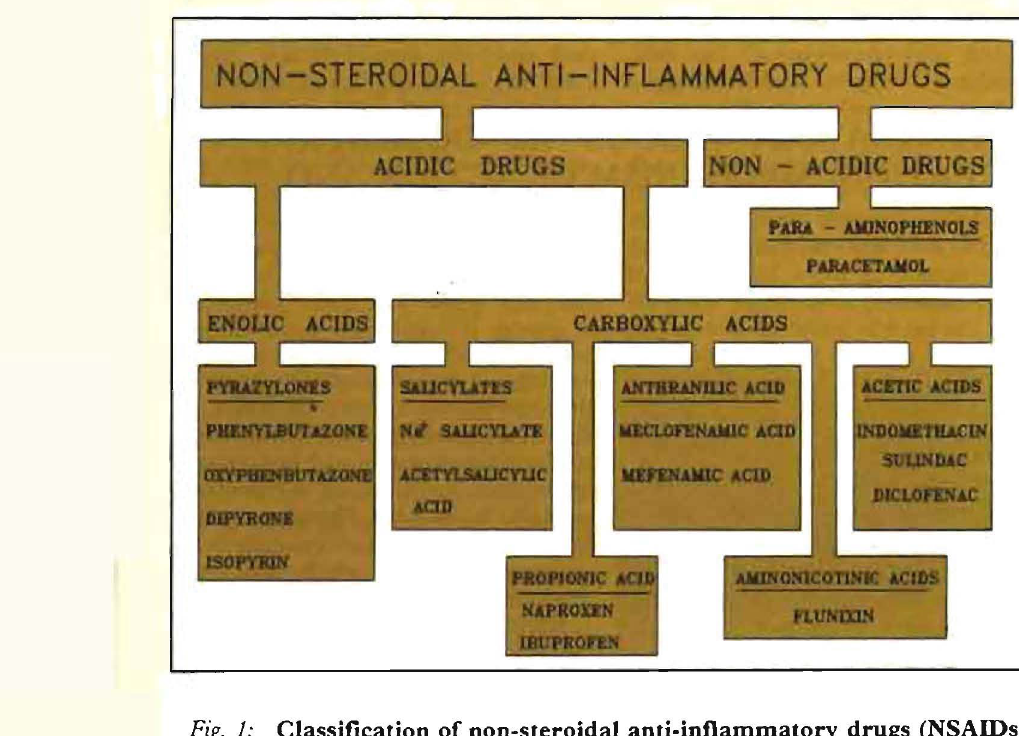
Fig. 1: Classification of non-steroidal anti-inflammatory drugs (NSAIDs) ferent physiological systems with